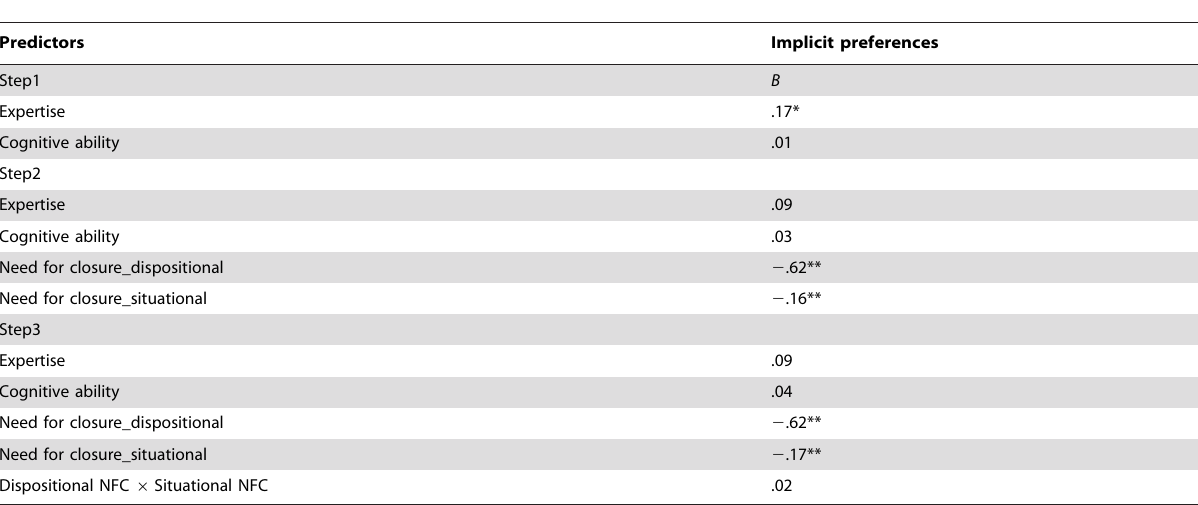
Table 5. Study two: Results of the moderated regression